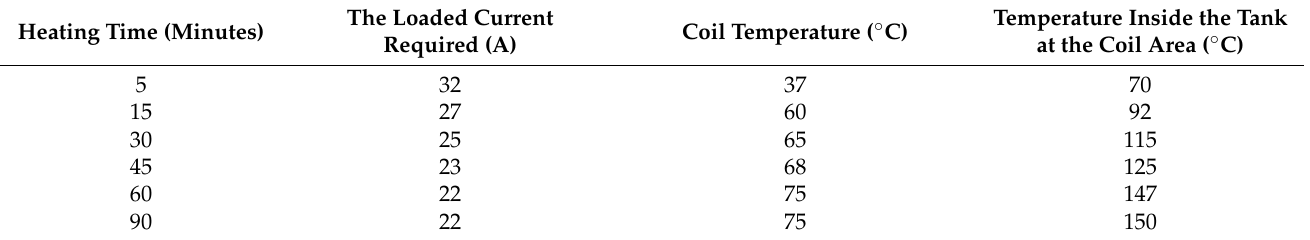
Table 2. Thermal measurements were performed using an infrared camera of the heat generated in the body over time and the current value that the load is drawn to.